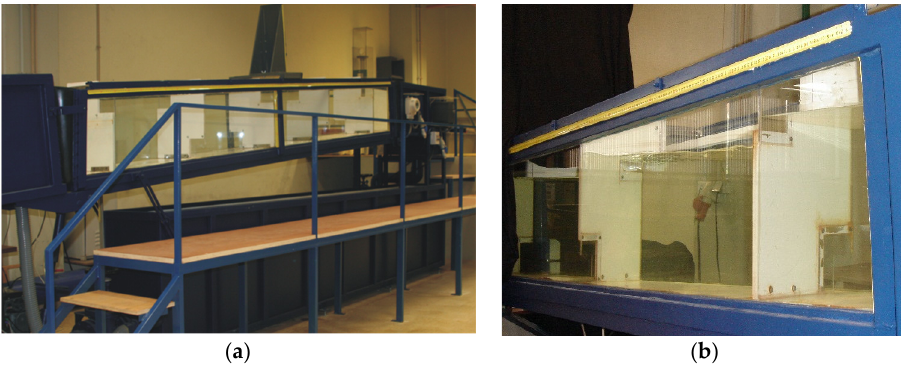
Figure 1. Experimental flume used ( a ) Side view of the flume; ( b ) Pool